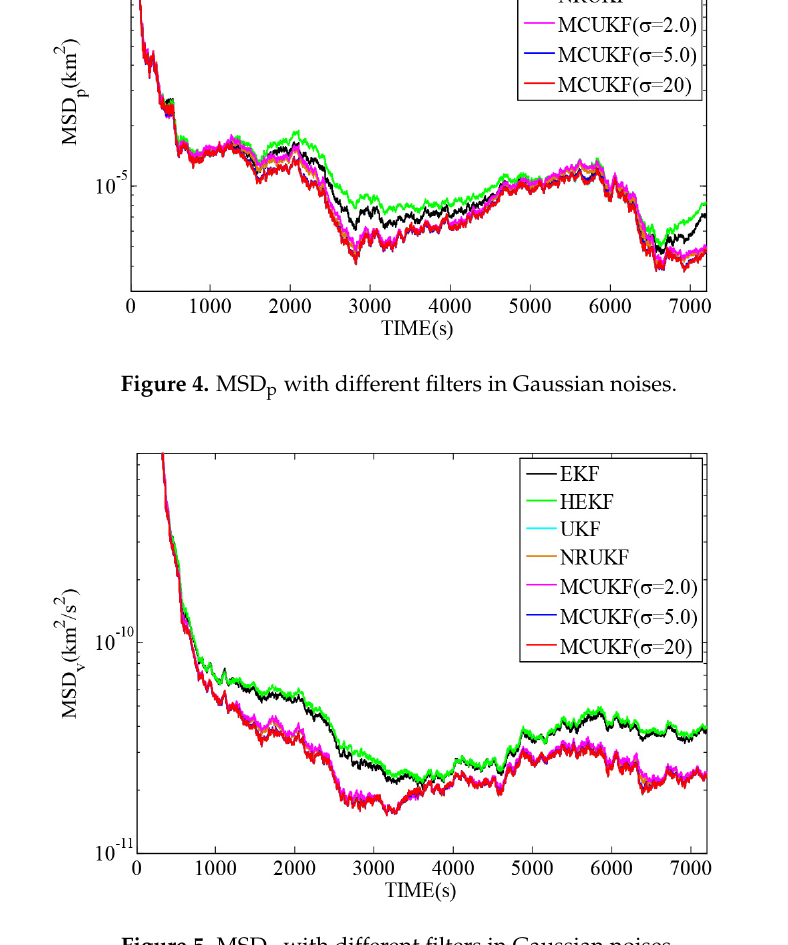
Figure 5. MSD v with different filters in Gaussian